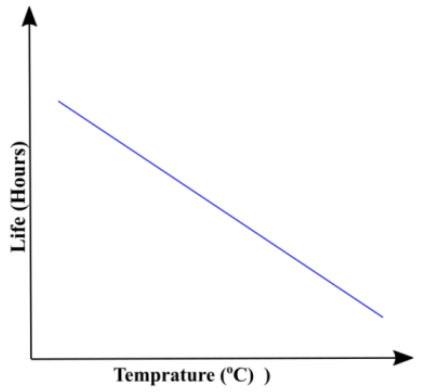
Figure 7. Thermal life graph between temperature and insulation life adapted with permission from [51].